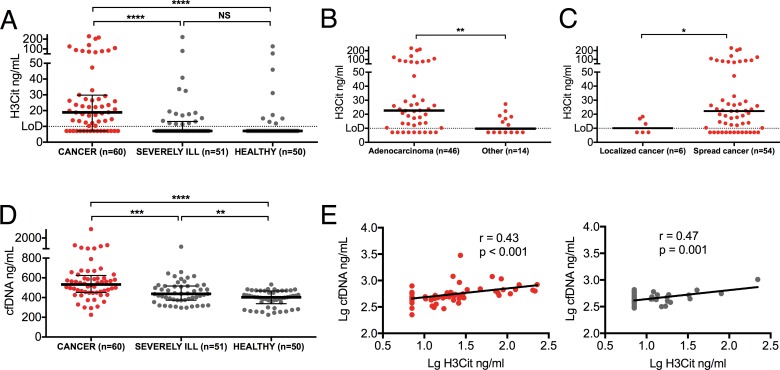
Elevations of plasma H3Cit and cfDNA in patients with advanced cancer.(A) Quantification of H3Cit showed increased levels in patients with advanced cancer compared to both healthy individuals and severely ill patients without known cancer. No significant difference in the levels of plasma H3Cit between severely ill patients without known cancer and healthy individuals were observed. (B) Plasma levels of H3Cit were significantly higher in patients with adenocarcinomas compared to patients with tumors of other histopathologies and (C) in patients with spread cancer compared to patients with localized tumors. (D) The levels of plasma cfDNA were significantly higher in cancer patients compared to both healthy individuals and severely ill patients without known cancer. The levels were also significantly higher in severely ill patients without known cancer compared to healthy individuals. (E) A significant positive correlation was found between plasma levels of H3Cit and cfDNA in cancer patients and in severely ill patients without known cancer. Lines represent medians with IQR. Groups were compared with the Mann-Whitney U test. Significance of correlation was analyzed with Pearson correlation coefficient after log transformed data to obtain a normal distribution. NS P > 0.05, * P < 0.05, ** P < 0.01, *** P < 0.001, **** P < 0.0001.